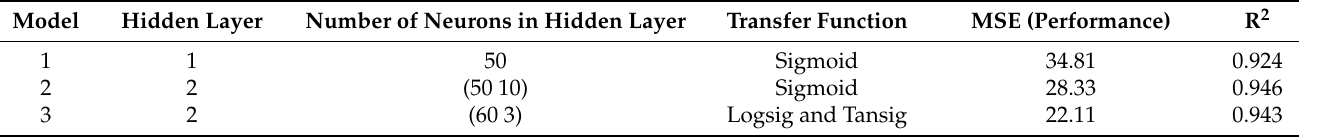
Table 6. Comparison of the